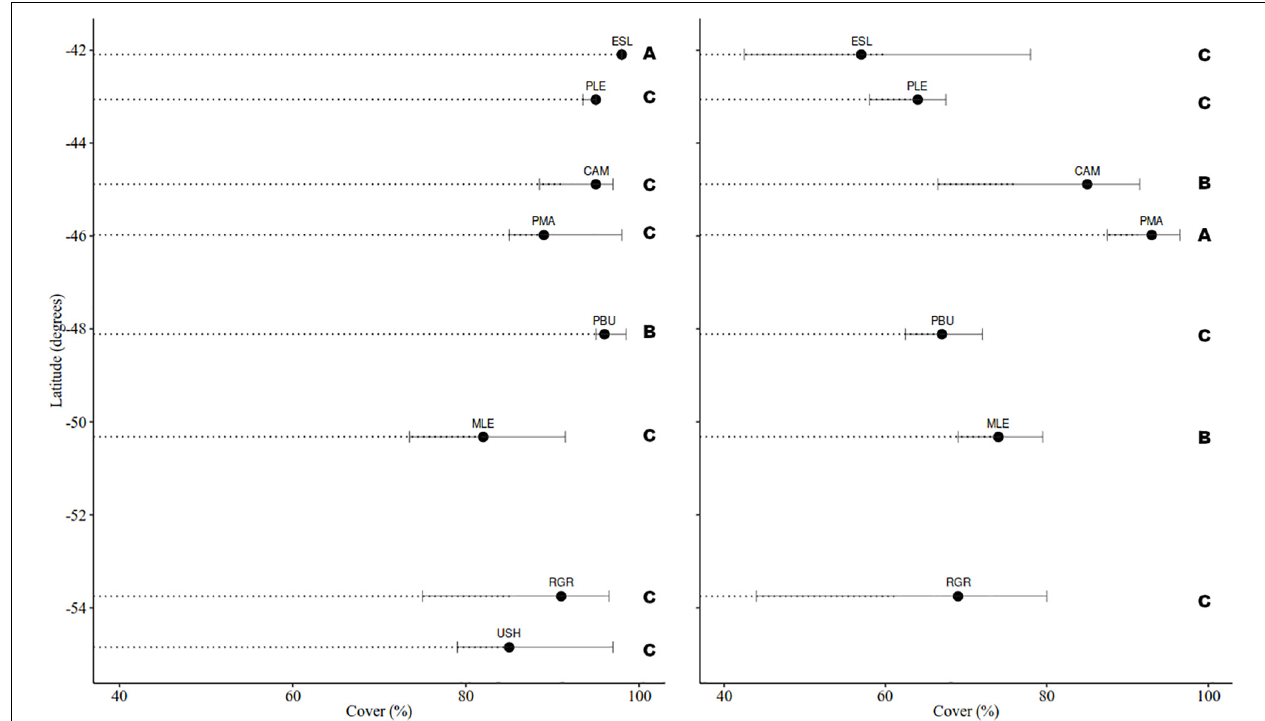
FIGURE 3 | Median cover (%) of mytilids in the mid intertidal level (left) and Corallina spp. in the low intertidal level (right). Bars represent the 25 and 75% percentile. Letters indicate differences among groups based on pairwise multiple comparison procedures (Student-Newman-Keuls Method).